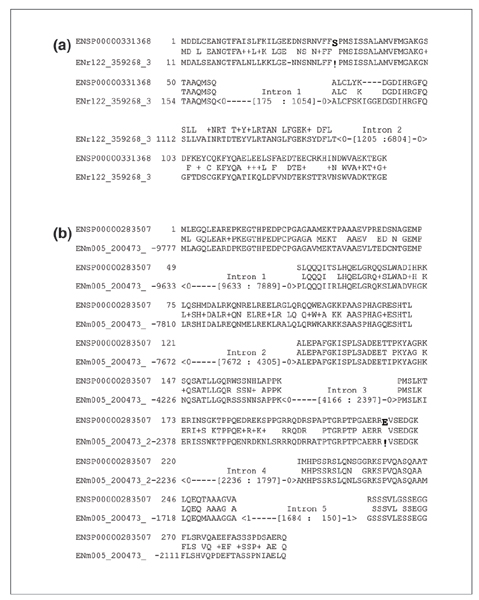
Two pseudogenes inconsistent with GENCODE gene annotation. (a) A pseudogene in ENr122: 359245-366200 (+) and its alignment with an ENSEMBL protein ENSP00000331368 (Serpin B8). This pseudogene overlaps a GENCODE gene whose transcript (ID: 'AC009802.2-001') contained the three pseudo-exons and one additional 5' exon. (b) A pseudogene at ENm005:200473-211501 (-) and its alignment with an ENSEMBL protein ENSP00000283507 (TCP-10 homolog). The first four pseudo-exons were included in a five-exon GENCODE transcript (ID: 'AP000274.7-001'). The frameshift mutations ('!' in the alignment) in both pseudogenes are highlighted.